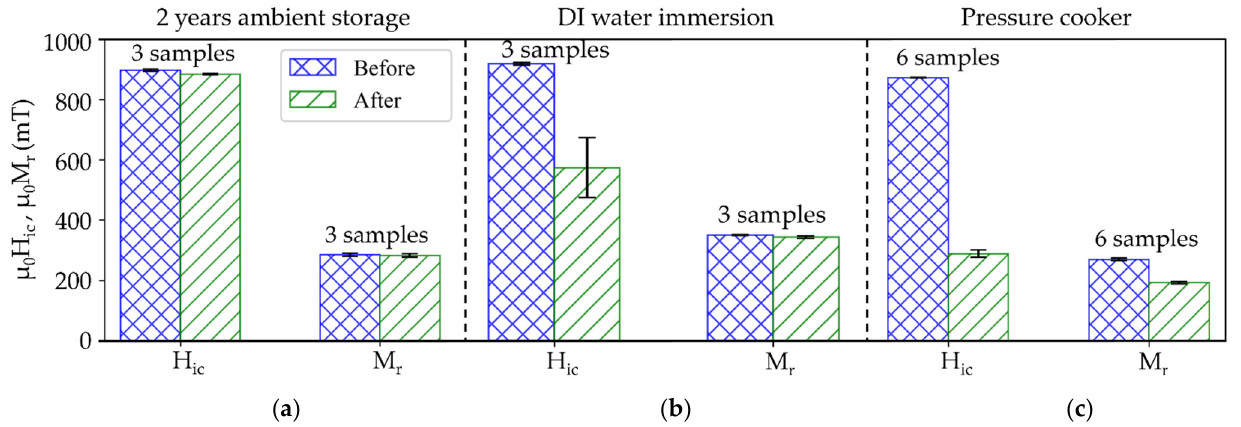
Figure 11. Magnetic properties of unpassivated NdFeB5 micromagnets before and after being sub- jected to different corrosion stability tests. ( a ) 2 years exposed to ambient conditions, ( b ) immersion test in DI water for 50 days and ( c ) pressure cooker test at 100% relative humidity and 120 °C for 96 h.